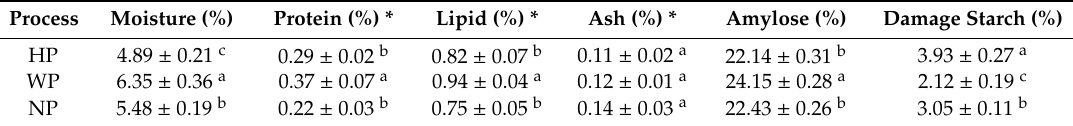
Table 1. Chemical composition of djulis starch by the three treatment procedures. Process